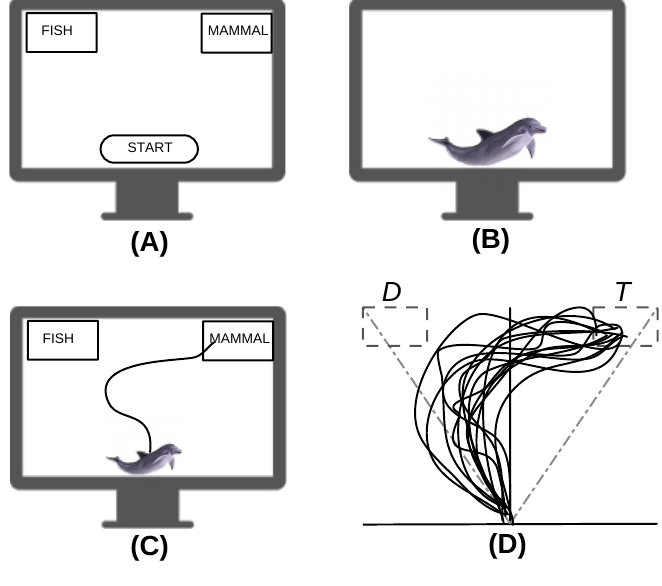
Figure 1. A typical mouse-tracking task: ( A , B ) Stimulus presentation, ( C ) participant’s response, ( D ) prototypical mouse-tracking trajectories for a set of participants and trials. Note that the correct response is presented on the top-right corner ( T ) whereas the corresponding competing response is presented on the top-left corner ( D